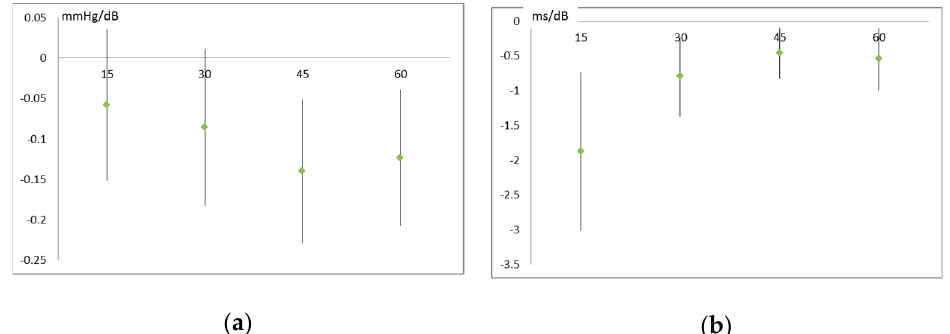
Figure 3. Effect of noise on cardiovascular parameters: ( a ) systolic blood pressure; ( b ) Standard deviation of intervals between two consecutive heartbeats. Noise levels are averaged over 15 min (4 periods per 1 h walk) each. Blood pressure was measured at the end of each period; electrocardiogram readings were taken over the whole 15 min period.